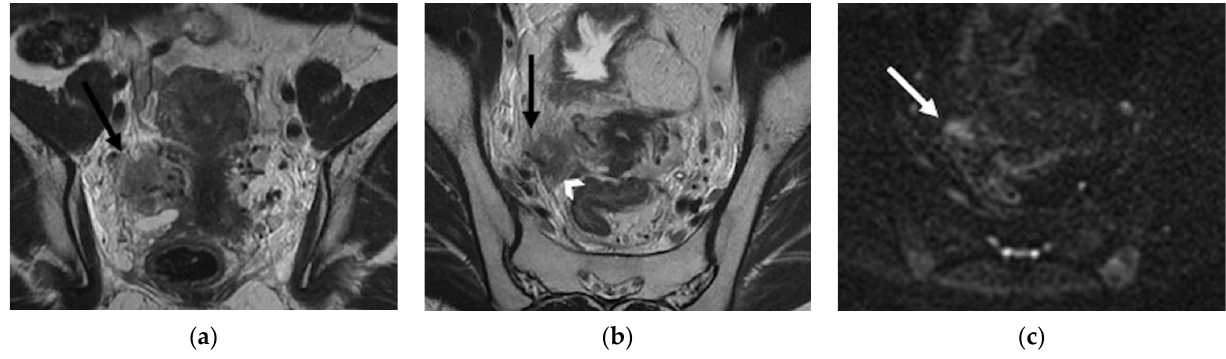
Figure 3. A 32-year-old woman who underwent previous chemoradiation therapy for cervical cancer. ( a ) Coronal and ( b ) axial FSE T2-weighted images show a soft-tissue mass in the right parametrium (black arrows). Note the contact with the right ureter embedded by the lesion (arrowhead). ( c ) Diffusion-weighted image shows focus of hyperintense signal into the lesion (white arrow). The finding was confirmed to be recurrence at surgery.